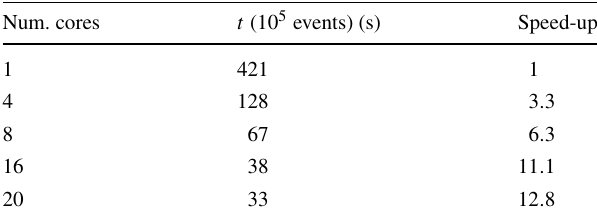
Table 1 Time taken for the ColliderBit LHC likelihood calculation as a function of the number of cores, for 100,000 SUSY events at the SPS1a parameter point [83,84], including all sub-processes. The pro- cesses were run on a single computer node, with ISR, FSR, and full hadronisation enabled, but multiple parton interactions and tau decay spin correlations disabled. GAMBIT was compiled with full optimisa- tion settings (cf. Sect. 11 of Ref. [1])